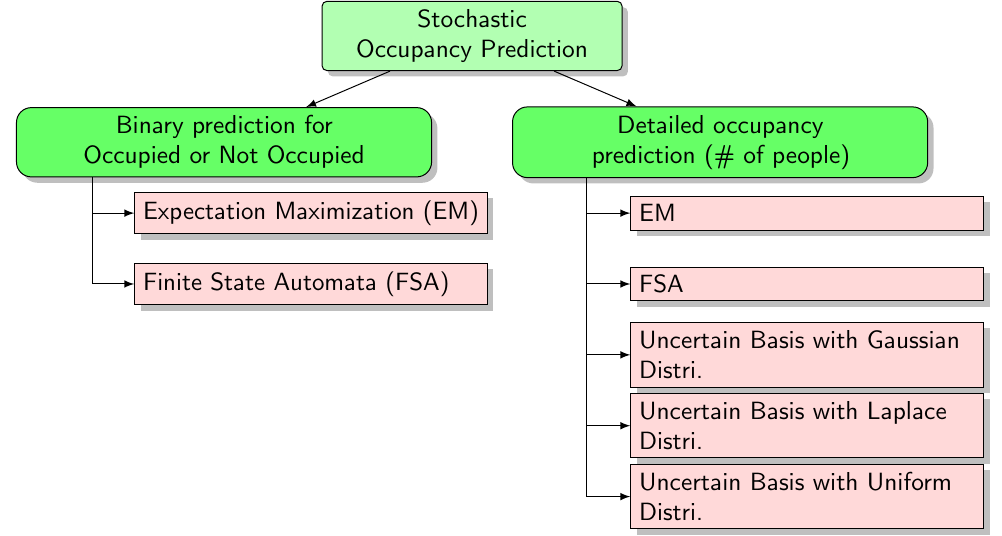
Figure 4. Overview of the occupancy prediction